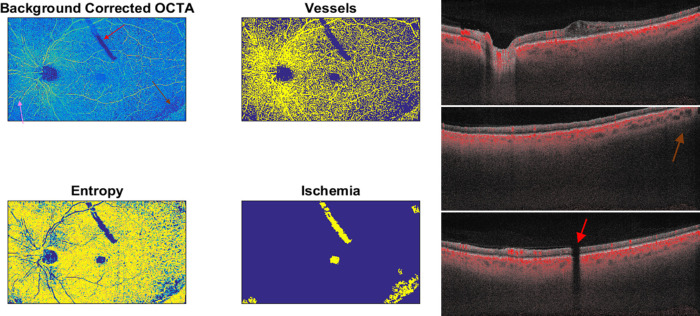
A representative OCTA scan that was excluded owing to many artifacts, such as a shadowing artifact related to dexamethasone implant clearly visible in the superior part of the scan (red arrow), motion artifacts with misalignment of retinal vessels (pink arrow), and low intensity signal in the peripheral edges of the scan because the retina was not within the focal range on the OCT B scan (brown arrow).